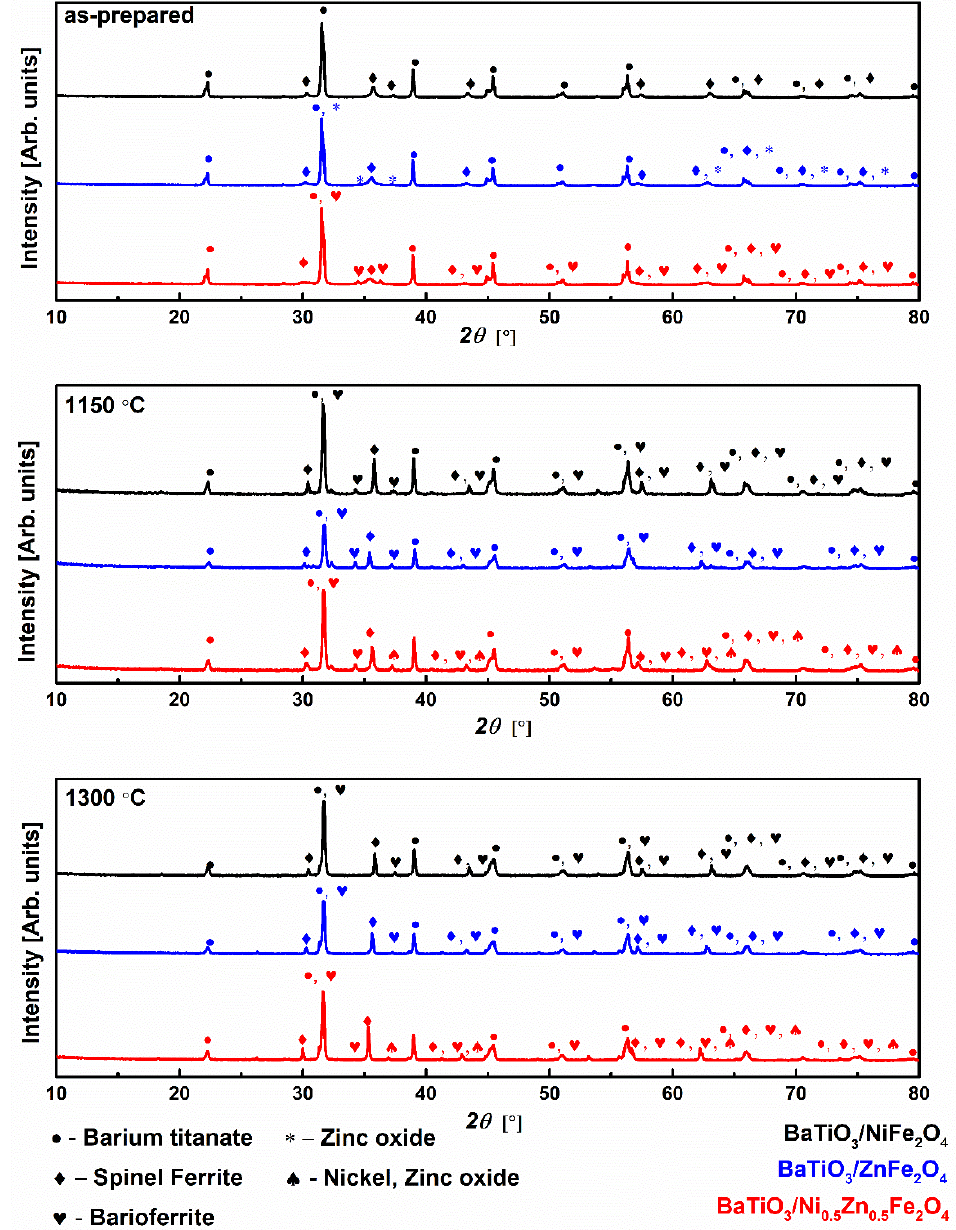
Figure 1. XRPD of BaTiO 3 /NiFe 2 O 4 , BaTiO 3 /ZnFe 2 O 4 , and BaTiO 3 /Ni 0.5 Zn 0.5 Fe 2 O 4 samples. Table 1. The phase composition of prepared composites. In parenthesis next to the phase chemical formulae crystal system and space group are presented as well as corresponding PDF card numbers from the ICDD database. Phase abundances are calculated by the RIR